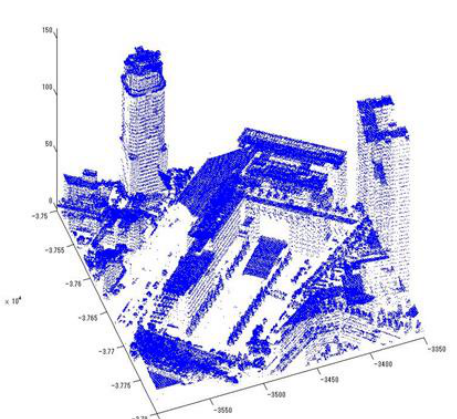
Figure 20. Visualized building with point cloud